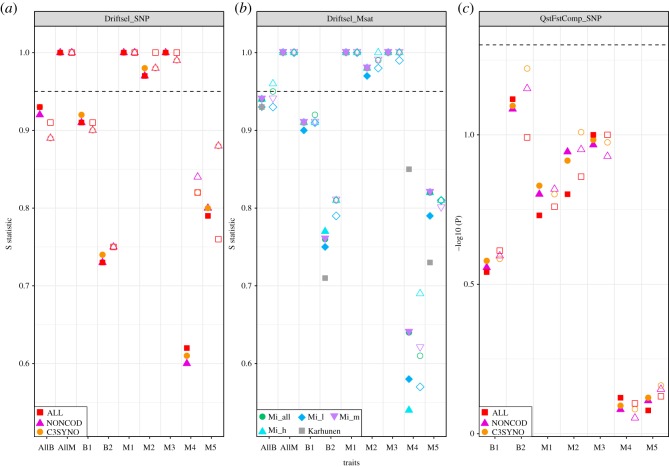
Effect of marker ascertainment, marker type and filtering of SNP dataset on QST-FST comparisons. Results of Driftsel analyses using SNP and microsatellite markers (a,b, respectively) and QstFstComp using SNP markers (b) are shown. (b) The Driftsel results with the 12 microsatellites used in [8] (Karhunen; grey squares) as well as for different sets of in silico microsatellites: all (Mi_all; green circles), ones with low number of alleles (Mi_l; blue diamonds); with intermediate number of alleles (Mi_m; purple triangles), and with high number of alleles (Mi_h; cyan triangles). (a,c) The results of Driftsel and QstFstComp, respectively, using all SNPs (‘ALL' dataset, red squares); non-coding/non-repeat sites (‘NONCOD' dataset, pink triangles) and codon 3rd position synonymous changes (‘C3SYNO’ dataset, orange circles). Values of the S statistic (Driftsel) or (−log10) p-values (QstFstComp) are reported on the y-axis and dashed lines correspond to the significance threshold for each method. For all panels, filled and open shapes correspond to whether or not the full datasets (filled) or datasets with variability-based ascertained markers (open) were used.